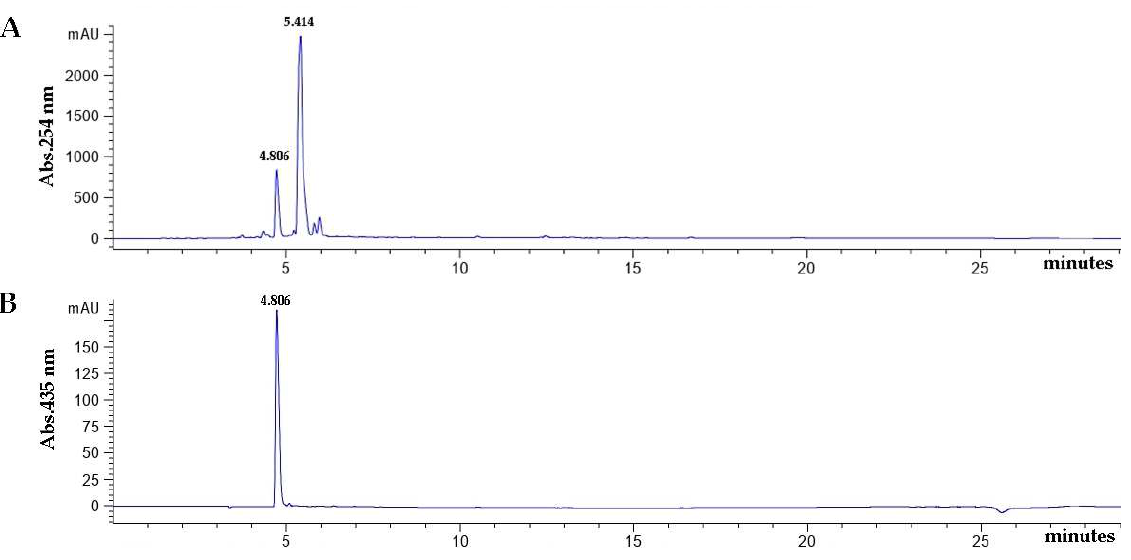
Figure 3. HPLC-visible chromatograms of the secreted siderophore extracts from the culture super- natant of T. marneffei ∆ sreA . The partially purified siderophore was analyzed by reverse-phase HPLC using absorbance determination at 254 ( A ) and 435 nm ( B ). The peak at retention times of 4.806 and 5.414 min are the ferri- (iron-bound) and desferri-form coprogen B siderophore, respectively.